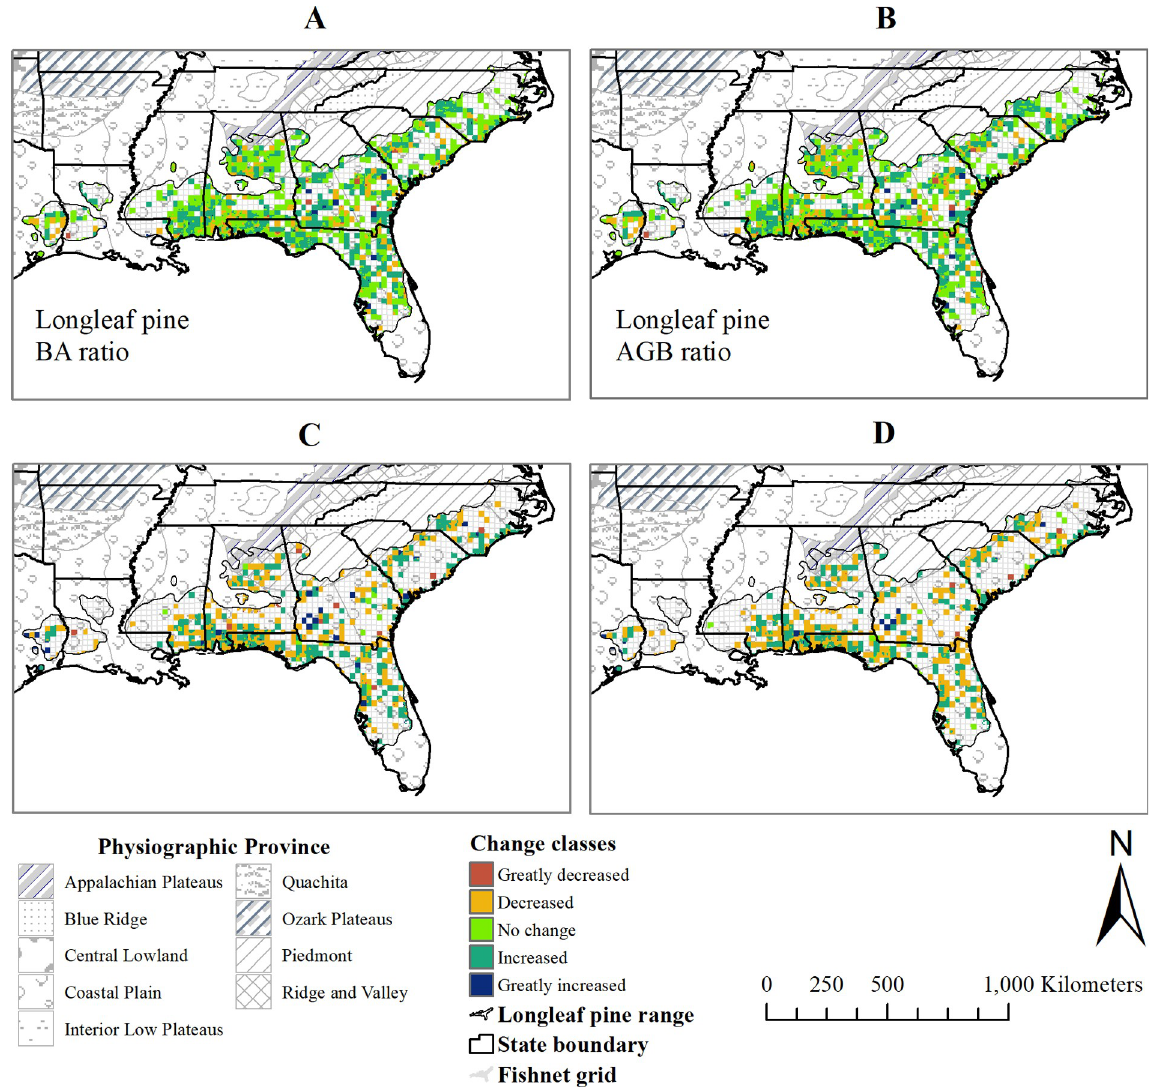
Fig 7. Change detection maps showing the spatial distribution of changes in longleaf pine (A) basal area (BA) ratio, (B) aboveground biomass (AGB) ratio, (C) basal area coefficient of variation, and (D) aboveground biomass coefficient of variation, in the study area between 2004 and 2011, where 2004 and 2011 are the centroid-year of first (1997–2010) and last (2003–2018) inventory intervals, respectively. (Shapefile data sources: US state boundary [25], Physiographic Province [21], and Longleaf pine range [26]). ( Quercus minima (Sarg.) Small) (S1 Table). Slash pine decreased substantially during the period, and possibly that favored other species more than it favored longleaf pine (Fig 5). Due to the reduction of fire frequency during the early and mid-20th century in longleaf pine forests, hard- woods increased in the midstory and overstory layers with a dominance of shrubs in the under- story [38]. Fire suppression causes the development of a scrub oak midstory in many existing xeric and subxeric sandhills longleaf pine forests. An earlier study [39] reported a shift in stand structure, favoring succession and high density of hardwoods because of the long-term exclu- sion of fire in old-growth longleaf pine forests in the Sandhills of North Carolina. In those old- growth longleaf pine forests, while black oak ( Quercus velutina Lam.), hickories ( Carya spp.), and large, sparse longleaf pines were dominant woody species on mesic sites, turkey oak and